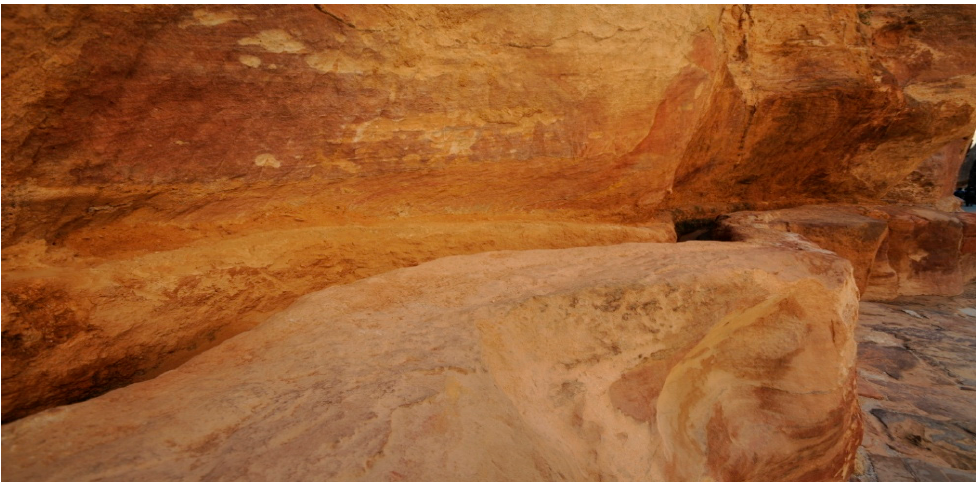
Figure 4. Channel cut to support pipeline water supply to the city center along the north wall of the Siq passageway. Pipeline continuation extends to the Outer Siq and further on to the city center.